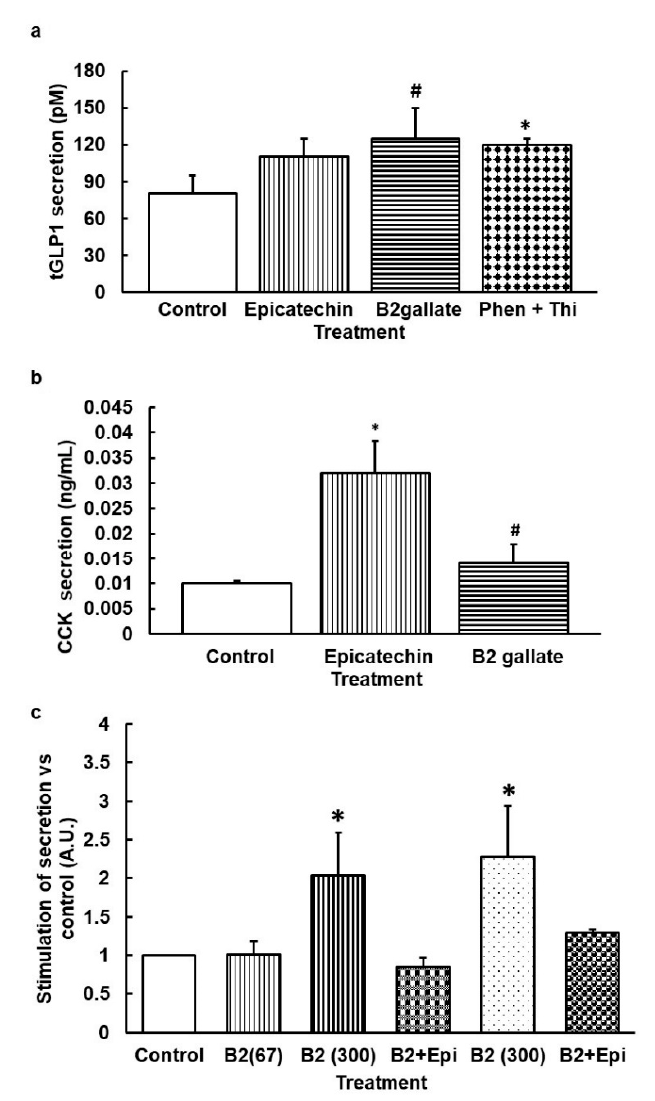
Figure 2. Ex vivo intestinal rat secretions induced by simultaneous stimulation by hTAS2R5 and hTAS2R39 agonist ( a ) and ( b ) or by Procyanidin B2 ( c ). ( a ) Segments of ileum were treated with epicatechin 1 mM, B2gallate 20 µ M for 30 min or 1,10-Phenantroline 150 µ M + Thiamine 1 mM for 45 min. ( b ) Segments of duodenum were treated with epicatechin 1 mM or B2gallate 20 µ M for 30 min. ( c ) Segments of ileum (for tGLP1, vertical and squared lines) and duodenum (for CCK, dotted columns) were treated with B2 67 or 300 µ M for 30 min, or B2 300 µ M + epicatechin 1 mM for 45 min. Afterwards, medium was collected and respective enterohormones in the medium were quantified by ELISA ( n = 6–10 segments). Mean ± SEM. ( c ) Results are calculated versus basal respective secretion in each hormone (Arbitrary Units, A.U.) * denotes p < 0.05 vs. control, # indicate p < 0.1 vs.